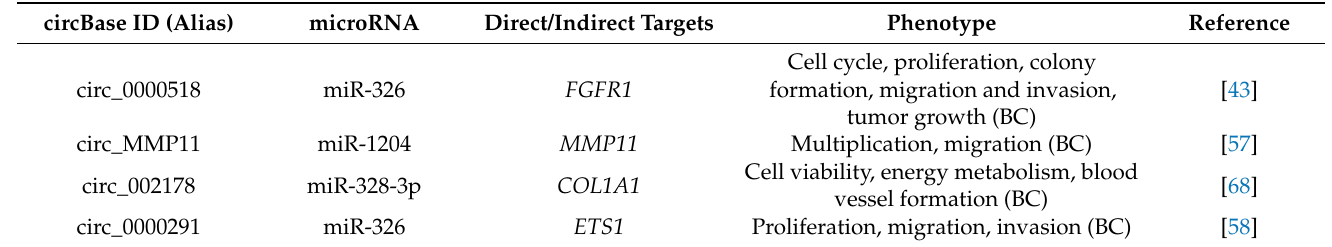
Table 1. The sponge function of cancer-promoting circRNA in BC and